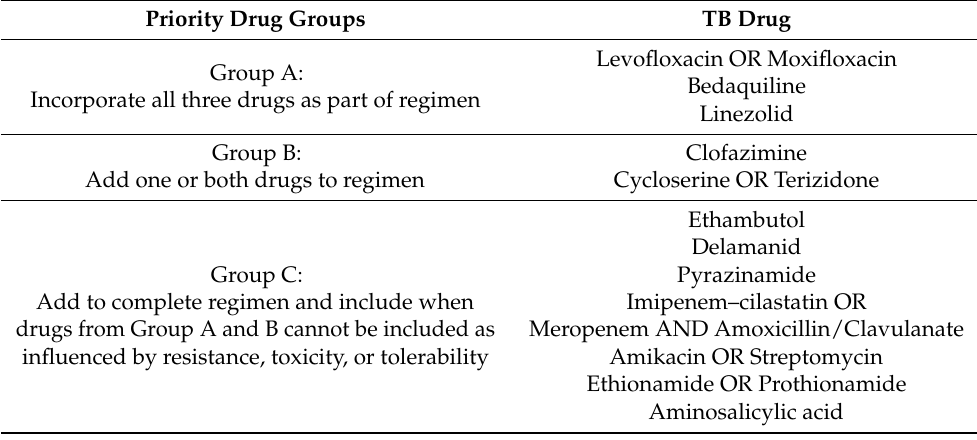
Table 1. Recent MDR-TB drug classification system for promoting an extensive MDR-TB treatment regimen as established by the WHO, adapted from